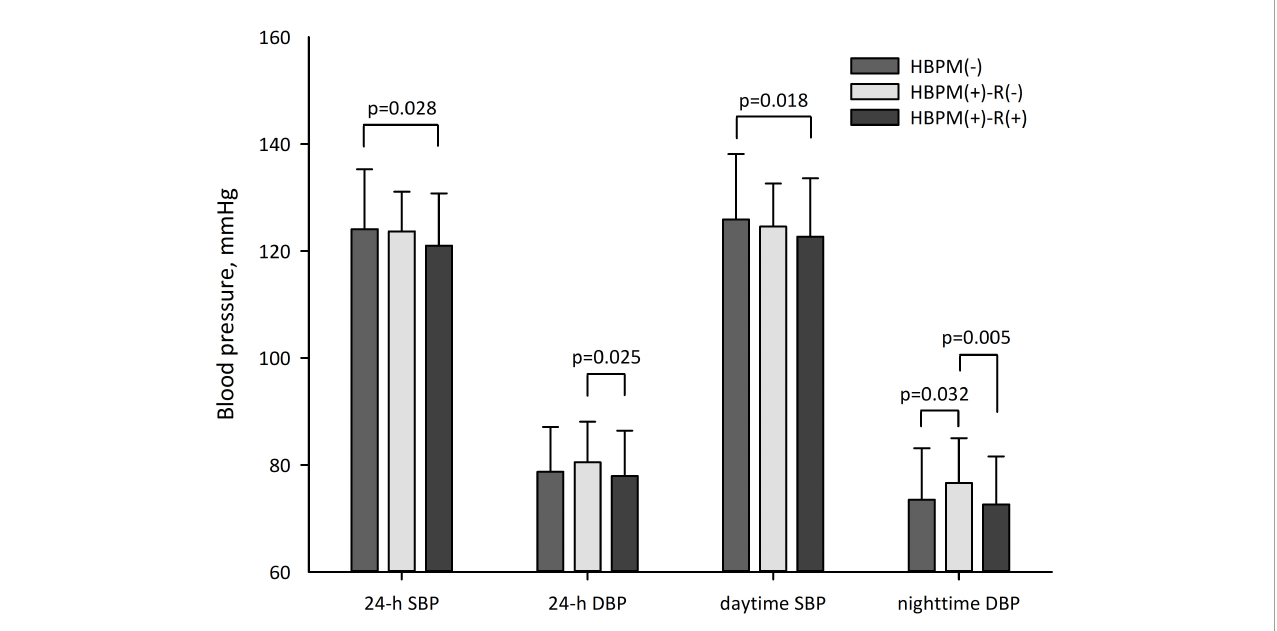
FIGURE1 Ambulatory blood pressure difference between groups. P -values were obtained by multivariate